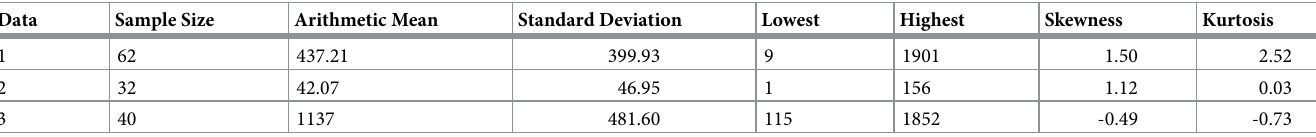
Table 9. The descriptive statistics related to D1, D2 and D3.